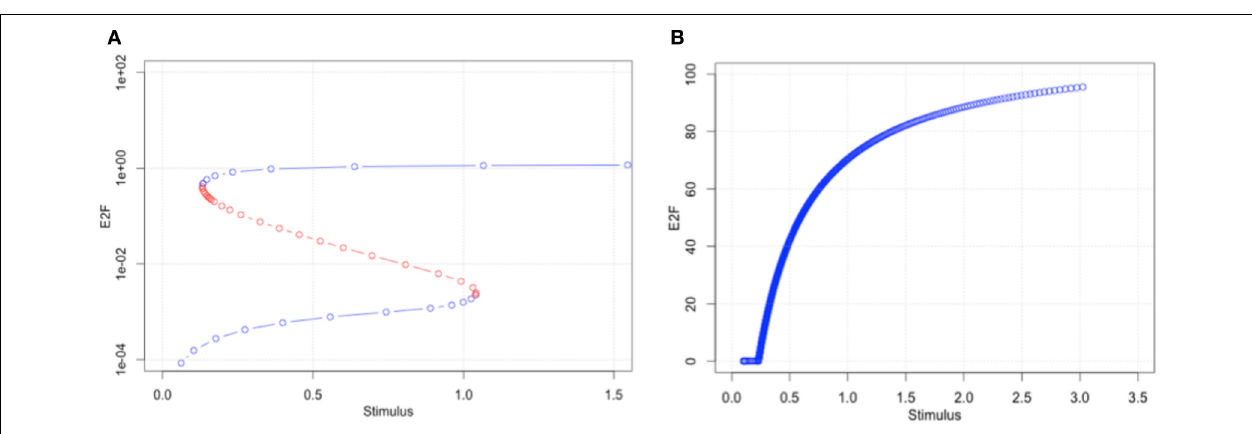
FIGURE 4 | Comparison of global parameter rank of the original parameter set with the 1st optimized parameter set. The blue line indicates the result of local sensitivity analysis with the original parameter set, and the red line indicates the result with the 1st optimized parameter set. (optimized → opmitized).